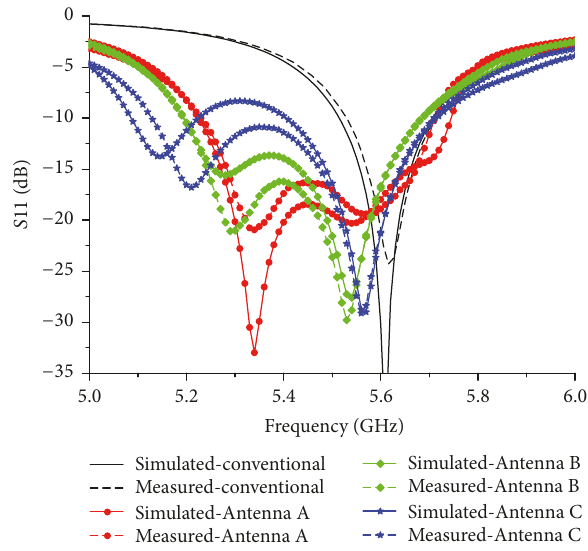
Figure 4: Comparisons of reflection coefficients for different